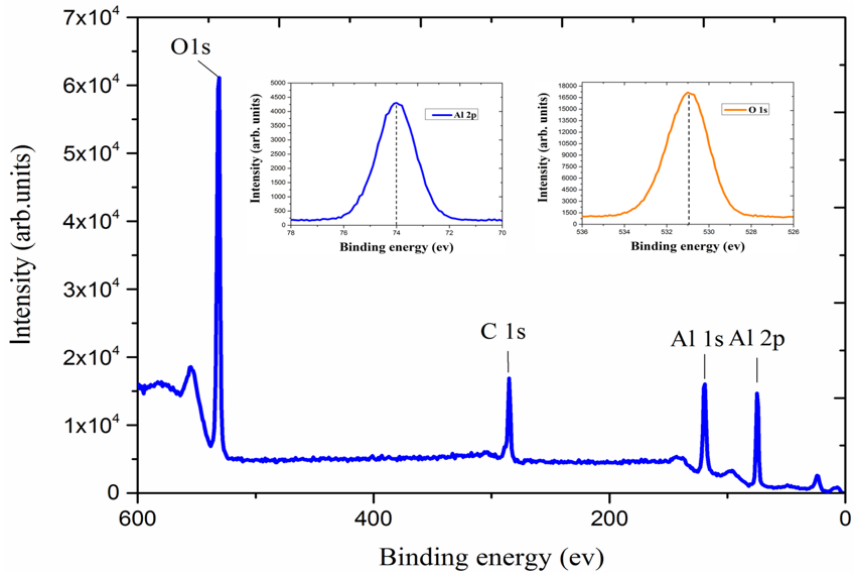
Figure 3. X-ray photoelectron spectra of the Al 2 O 3 layer deposited at 300 °C. The two insets show the Al (2p) and O (1s) peaks, respectively.